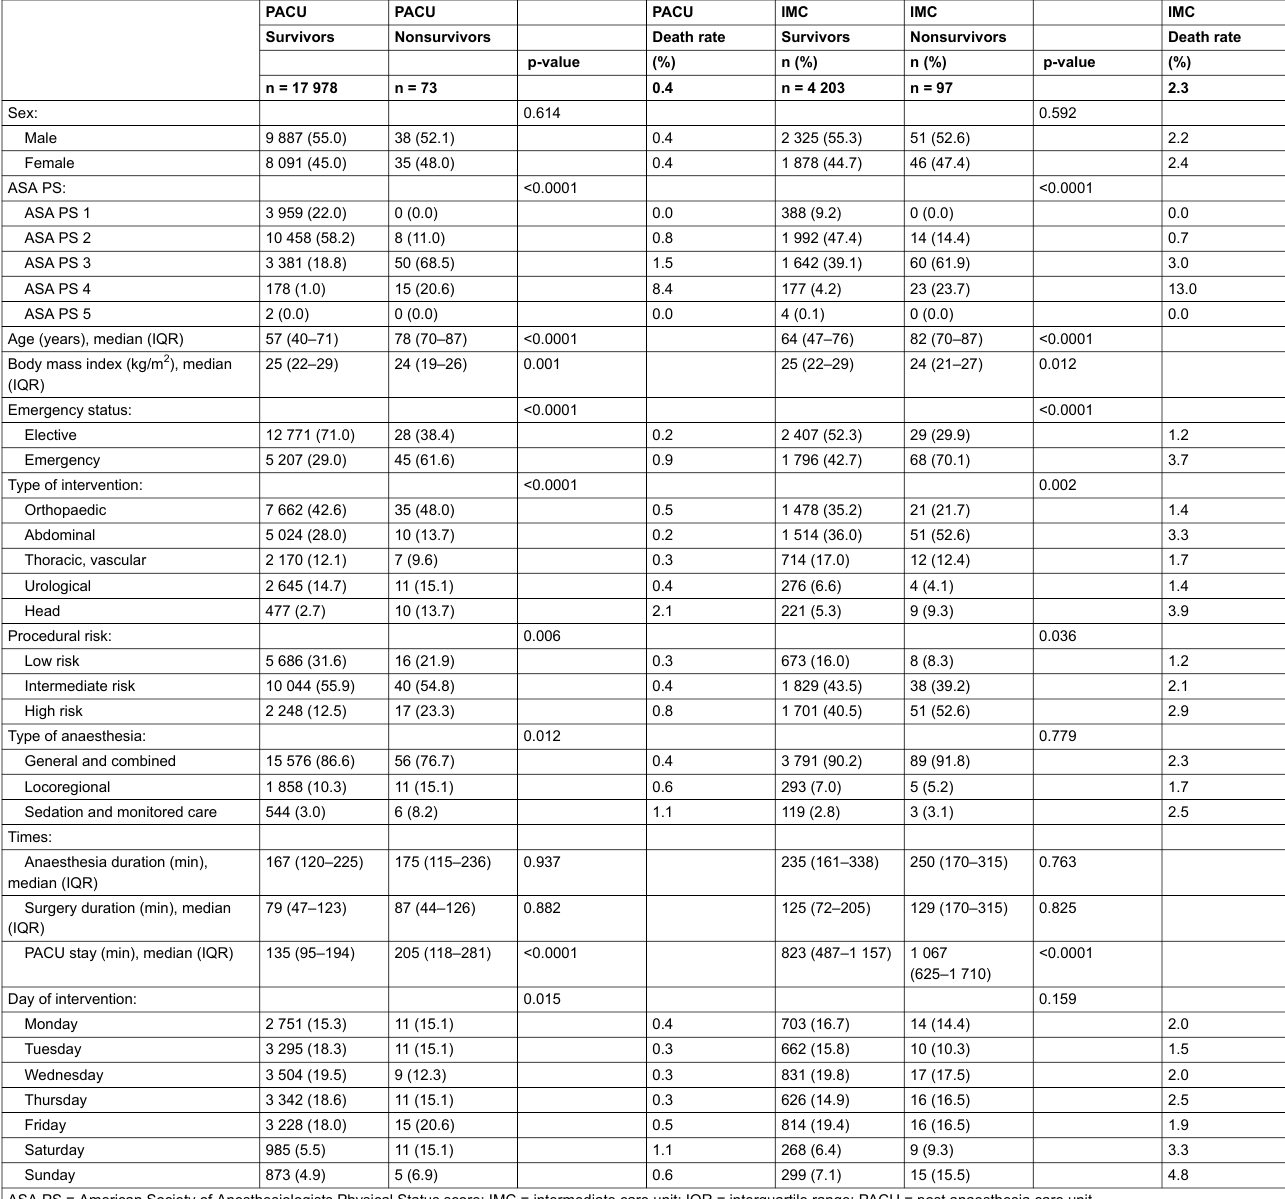
Table 2b: Characteristics of survivors and nonsurvivors (30-day in-hospital mortality) with a PACU or an IMC